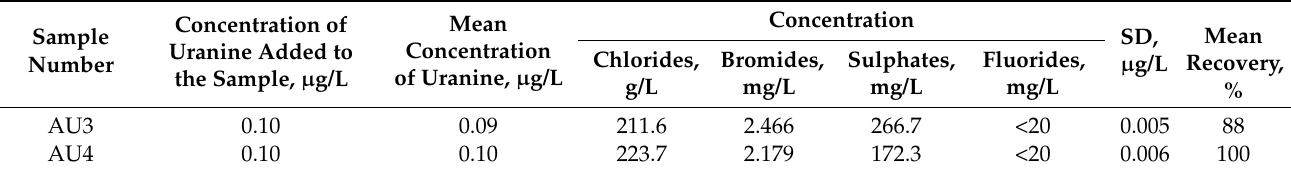
Table 7. Measurement and calculation results obtained from the method selectivity